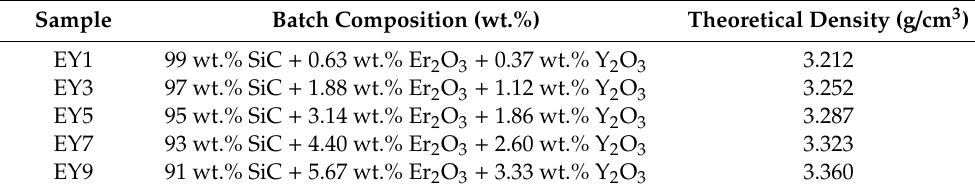
Table 1. Batch composition and theoretical density of SiC ceramics